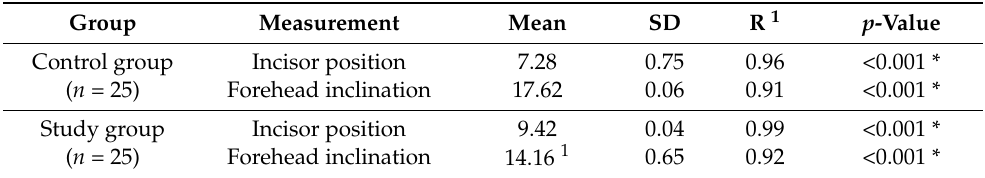
Table 1. Measurement error analysis.